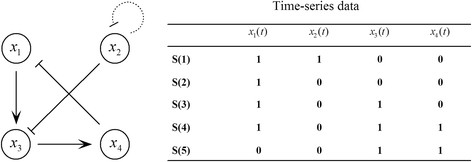
An example of four genes.